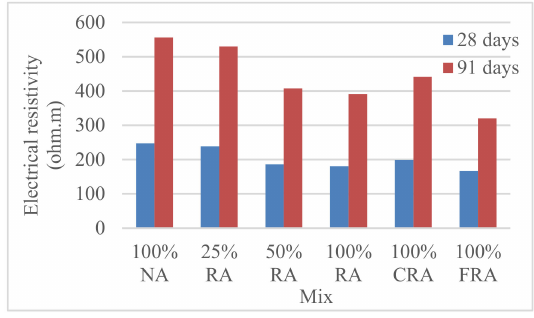
Figure 15. Electrical resistivity results at 28 and 91 days.